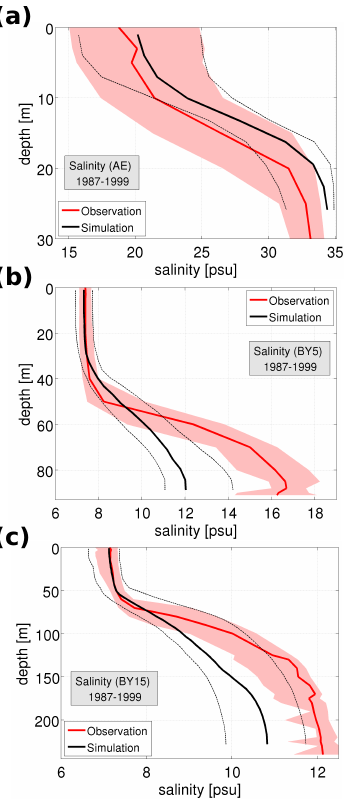
Figure 16. Median salinity profiles for the period 1987–1999 with Fig. 16. Median salinity profiles for the period 1987–1999 with 10th- and 90th-percentiles at 10th and 90th percentiles at stations AE, BY5 and BY15 in panels stations AE, BY5 and BY15 in panels (a) , (b) and (c) respectively. The locations of the stations (a) , (b) and (c) respectively. The locations of the stations are indi- are indicated in Fig. 1. Observations refer to SHARK. cated in Fig. 1. Observations refer to SHARK.